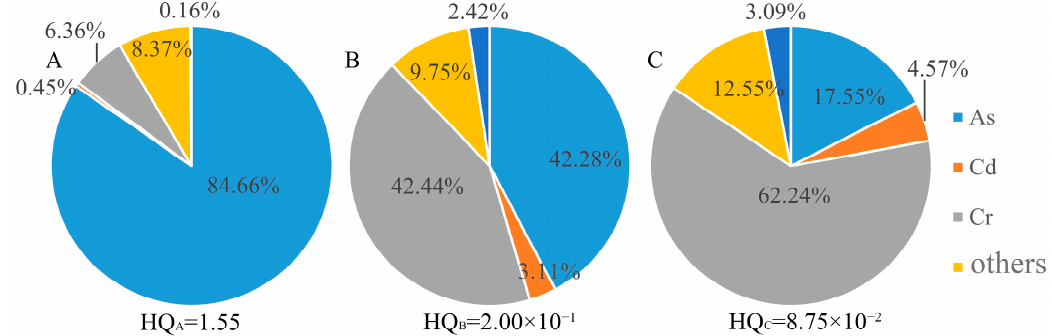
Figure 8. Noncarcinogenic risk contribution rate for soil-heavy metals. A, B and C represent area A, area B and area C, respectively.